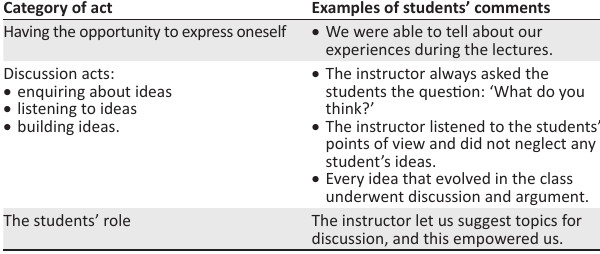
TABLE 9 : Pedagogic acts that encourage dialogue. Category of act